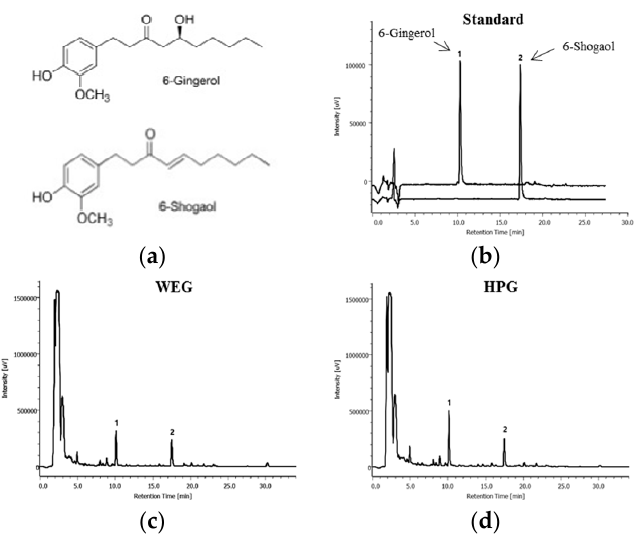
Figure 1. High-performance liquid chromatography (HPLC) analysis of ginger extracts. ( a ) Chemical structures of 6-gingerol and 6-shogaol; HPLC chromatogram of ( b ) standard, ( c ) hot water extract of ginger (WEG), and ( d ) high-hydrostatic pressure extract of ginger (HPG).